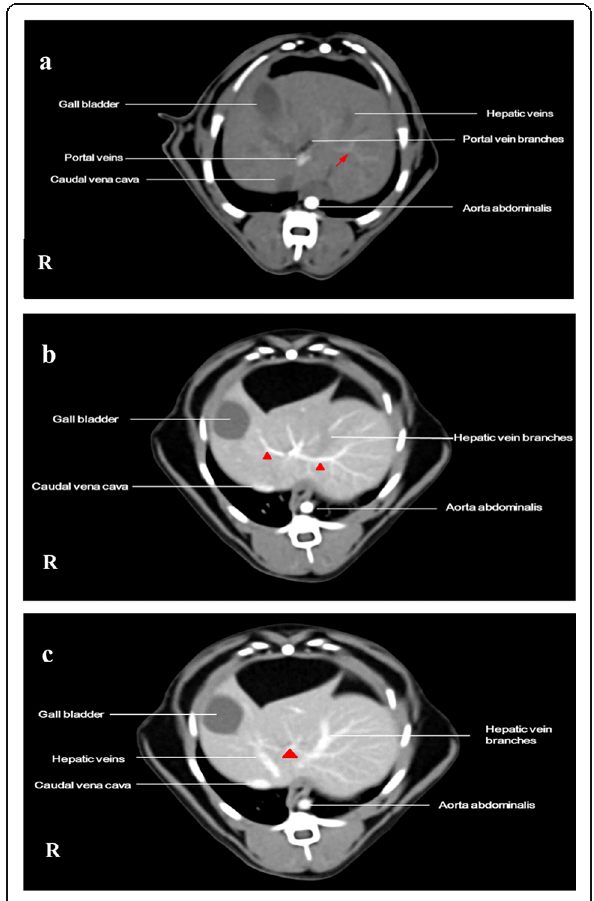
Fig. 5 CT images of hepatic vascular anatomy at three different delay times in cats. Hepatic arteries (red arrow) and partly enhanced portal vein lumens were seen in the arterial phase ( a ). In the portal venous phase ( b ), portal vein (red triangles) branches were hyperenhanced, whereas in the portal phase ( c ), the contrast agents were transferred to hepatic veins (red triangle). CT images were analyzed in a soft tissue window (W/L: 400/40)